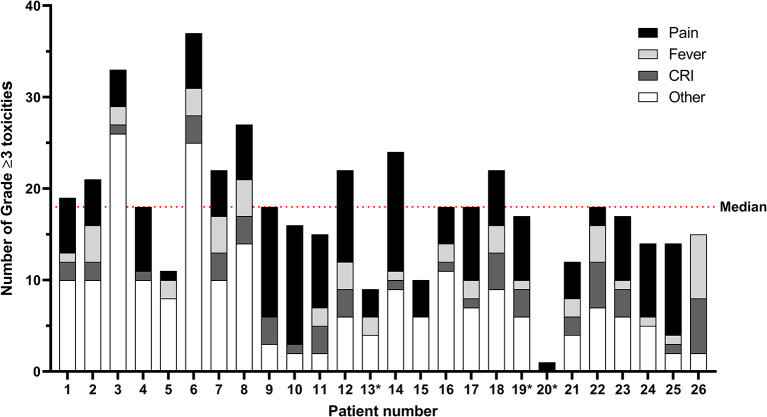
Immunotherapy-related grade ≥ 3 toxicities per patient for courses 1–5. Toxicities may be documented multiple times per course, with a maximum of once per day. The median number of grade ≥3 toxicities per patient is 18 (range 10–37) for the 23 patients who completed all six courses of immunotherapy. The category “Other” comprises toxicities in alphabetical order from the CTCAE categories Allergy; Blood/bone marrow; Constitutional, Cardiac; Gastrointestinal, Infection; Lymphatics; Metabolic/laboratory; Neurology; Ocular/visual; Pulmonary; and Vascular. All individual toxicities encountered are listed in Supplementary Table 2. *Patients 13, 19, and 20 did not complete all cycles of immunotherapy. CRI, catheter-related infections.